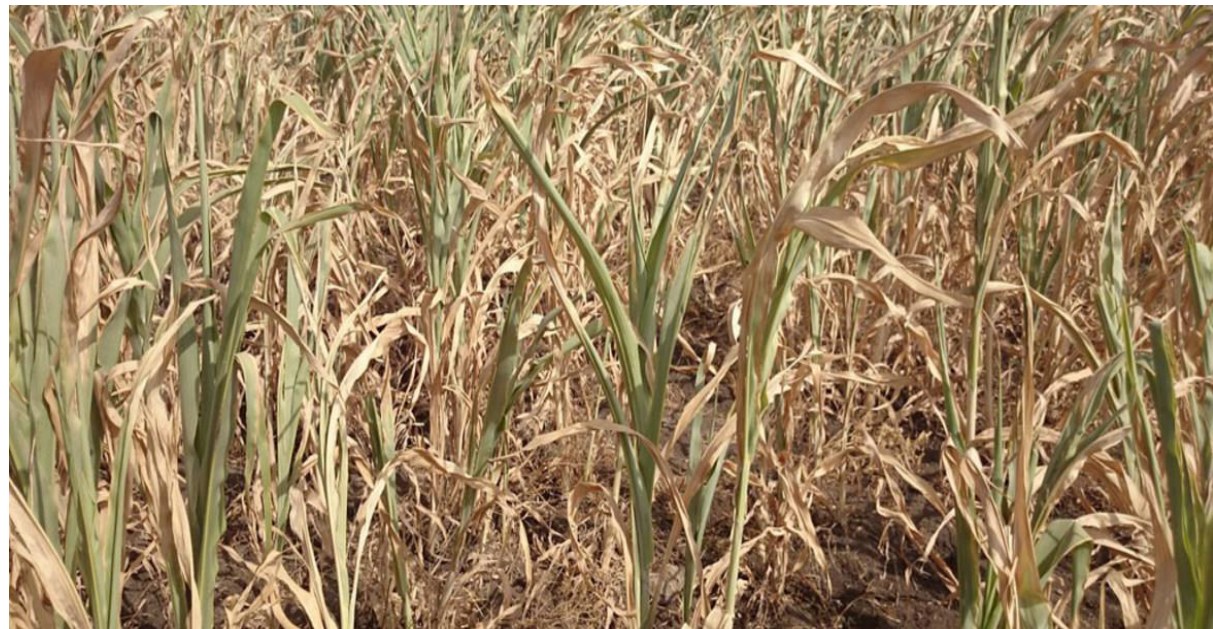
Figure 1. Impacts of drought stress in sorghum in Ethiopia, Photos—January